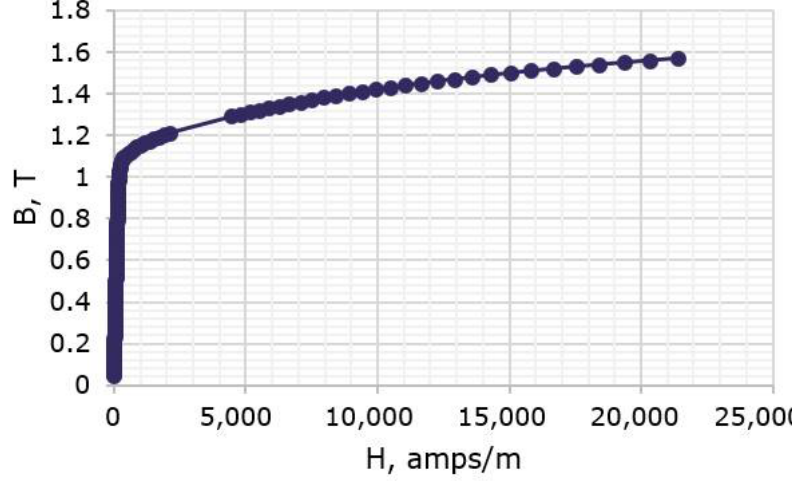
Figure 11. B-H curve of printed steel [19,20].